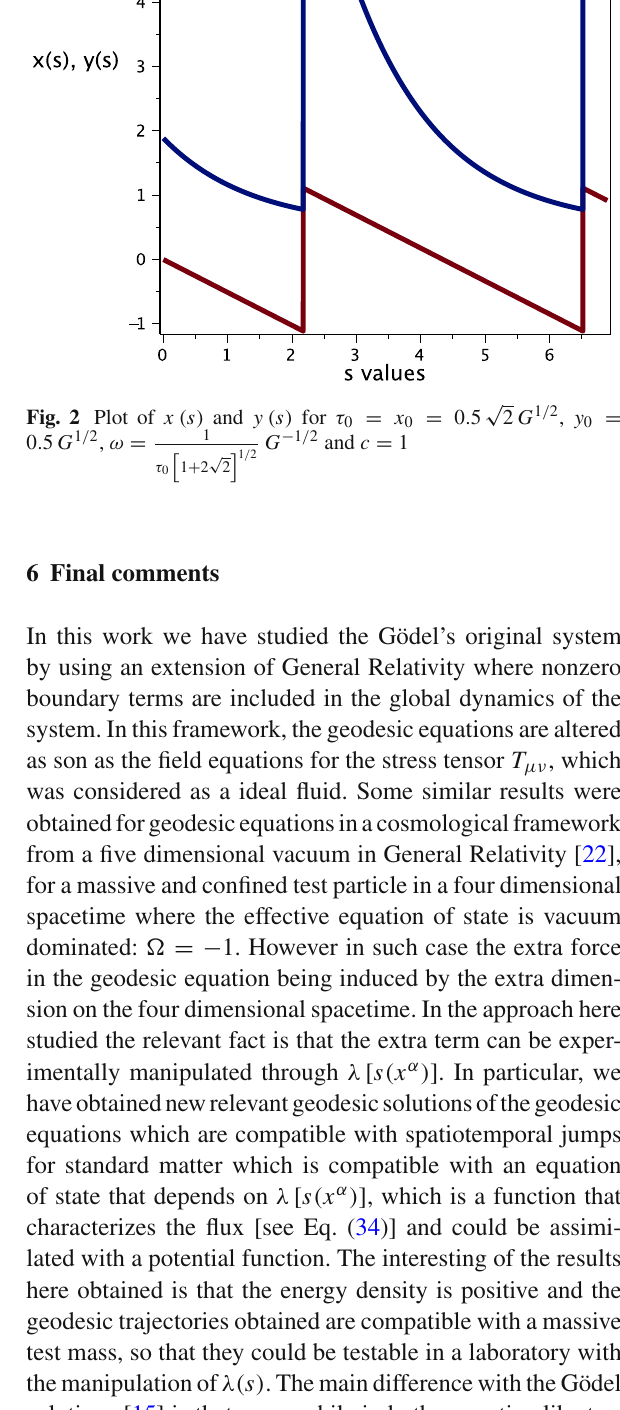
√ 2 G 1 / 2 , y 0 = 0 . 5 G 1 / 2 , ω =